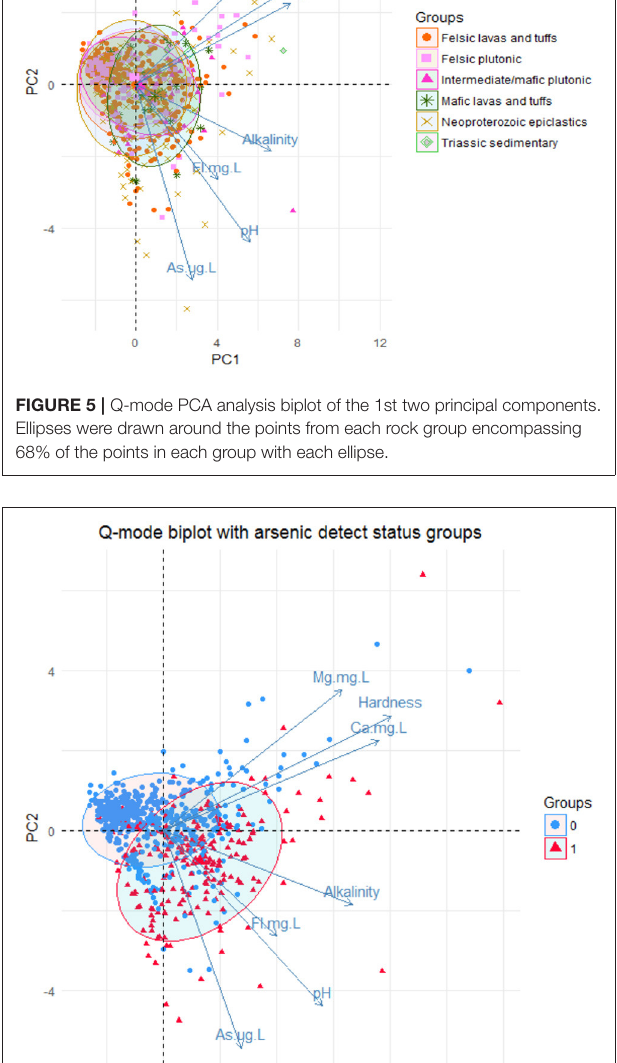
similar to the trend of the Carolina Terrane. This directionality was also noted by Kim et al. (2011). Also in support of this connection is the high average arsenic concentration for